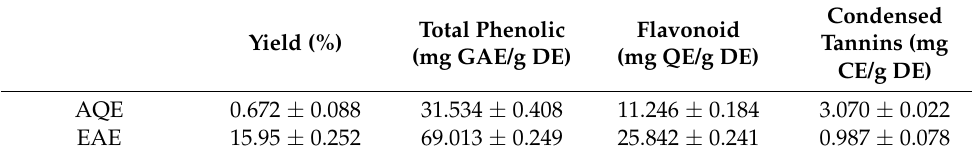
Table 1. The yield of extraction and the contents of the total phenolic compounds, flavonoids, and condensed tannins in A. absinthium extracts.